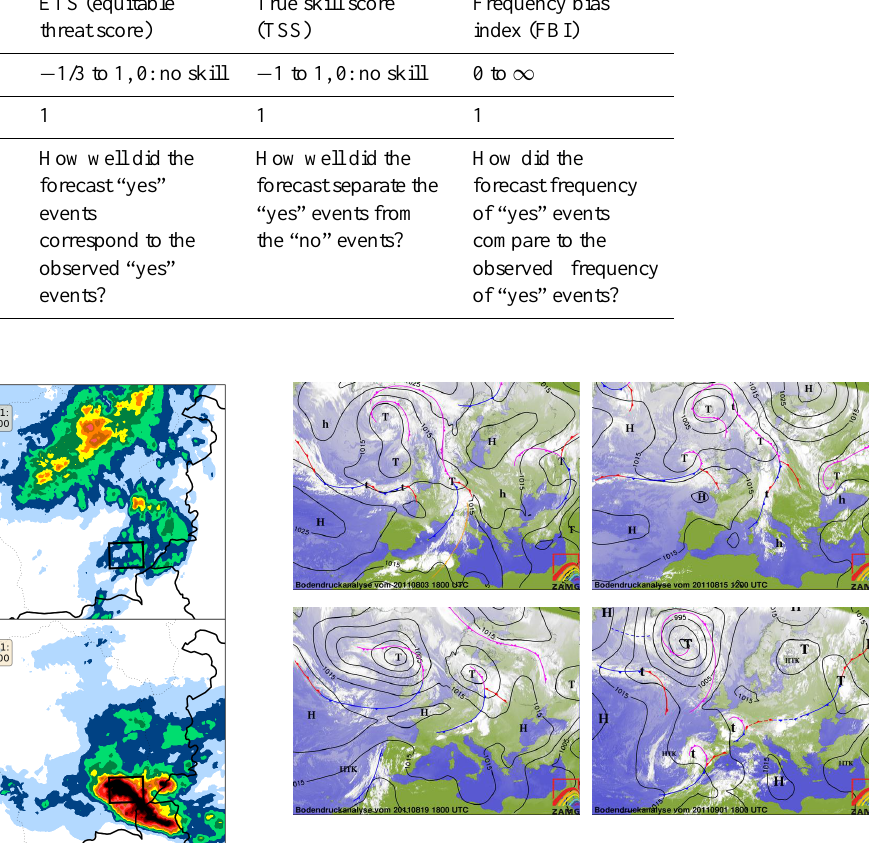
Figure 5. Satellite image, surface pressure analysis and frontal zones on the 4 selected days. Top left: 3 August 2011, 18:00UTC; top right: 15 August 2011, 12:00UTC; bottom left: 19 August 2011, 18:00UTC; bottom right: 1 September 2011, 18:00UTC. topography (represented by the orange line in Fig. 5, top left) indicates high values of temperature and humidity in the southeastern part of Austria. CAPE values in the WegenerNet area amount to more than 2000 J kg − 1 and the lifted index (LI) is around − 6 K, thus indicating a potential for convec-